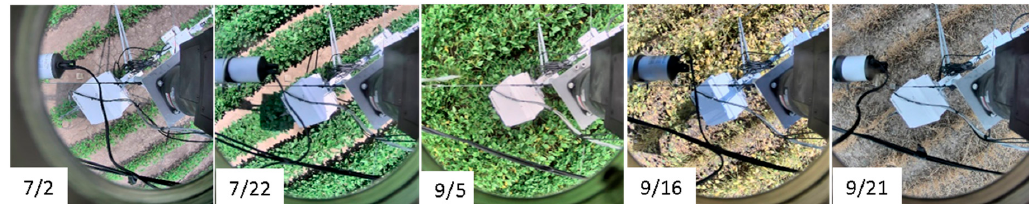
Figure 4. Selected RGB photos captured at one of the 12 positions ( − 146 degrees) around the EcoSpec tower during the 2015 growing season. These photos show phenology of plants and provide contextual information to aid analyses of measurements collected using the EcoSpec